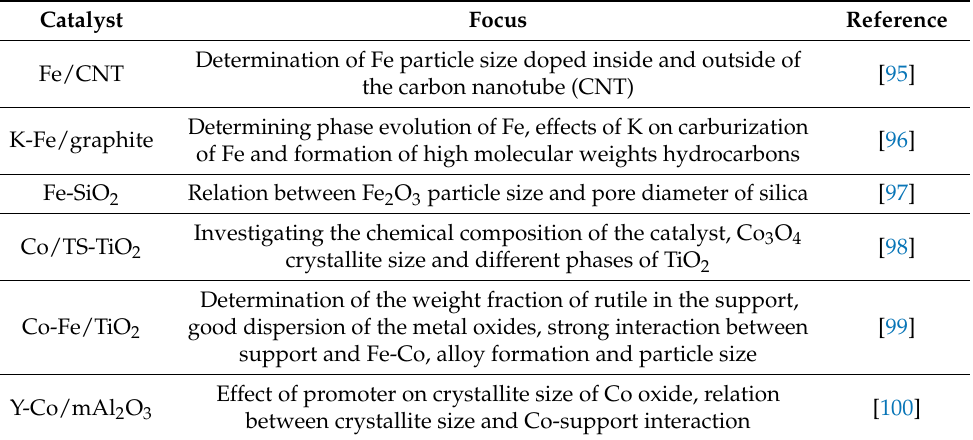
Table 5. Characterization of Fe- and Co-based FT catalysts by XRD technique.